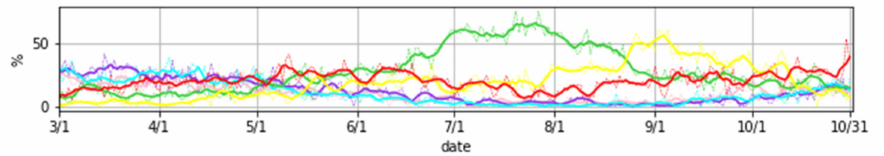
Figure 4. The 41-year (1979–2019) averaged frequency (percentage) of the six WTs (thin curves) from 1 March to 31 October (245 days/year). The thick curves are the 5-day running average. Color: WT1 (pink), WT2 (purple), WT3 (light blue), WT4 (green), WT5 (yellow), WT6